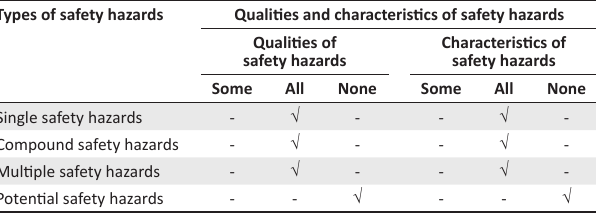
TABLE 6: Types of safety hazards meeting safety hazard qualities and